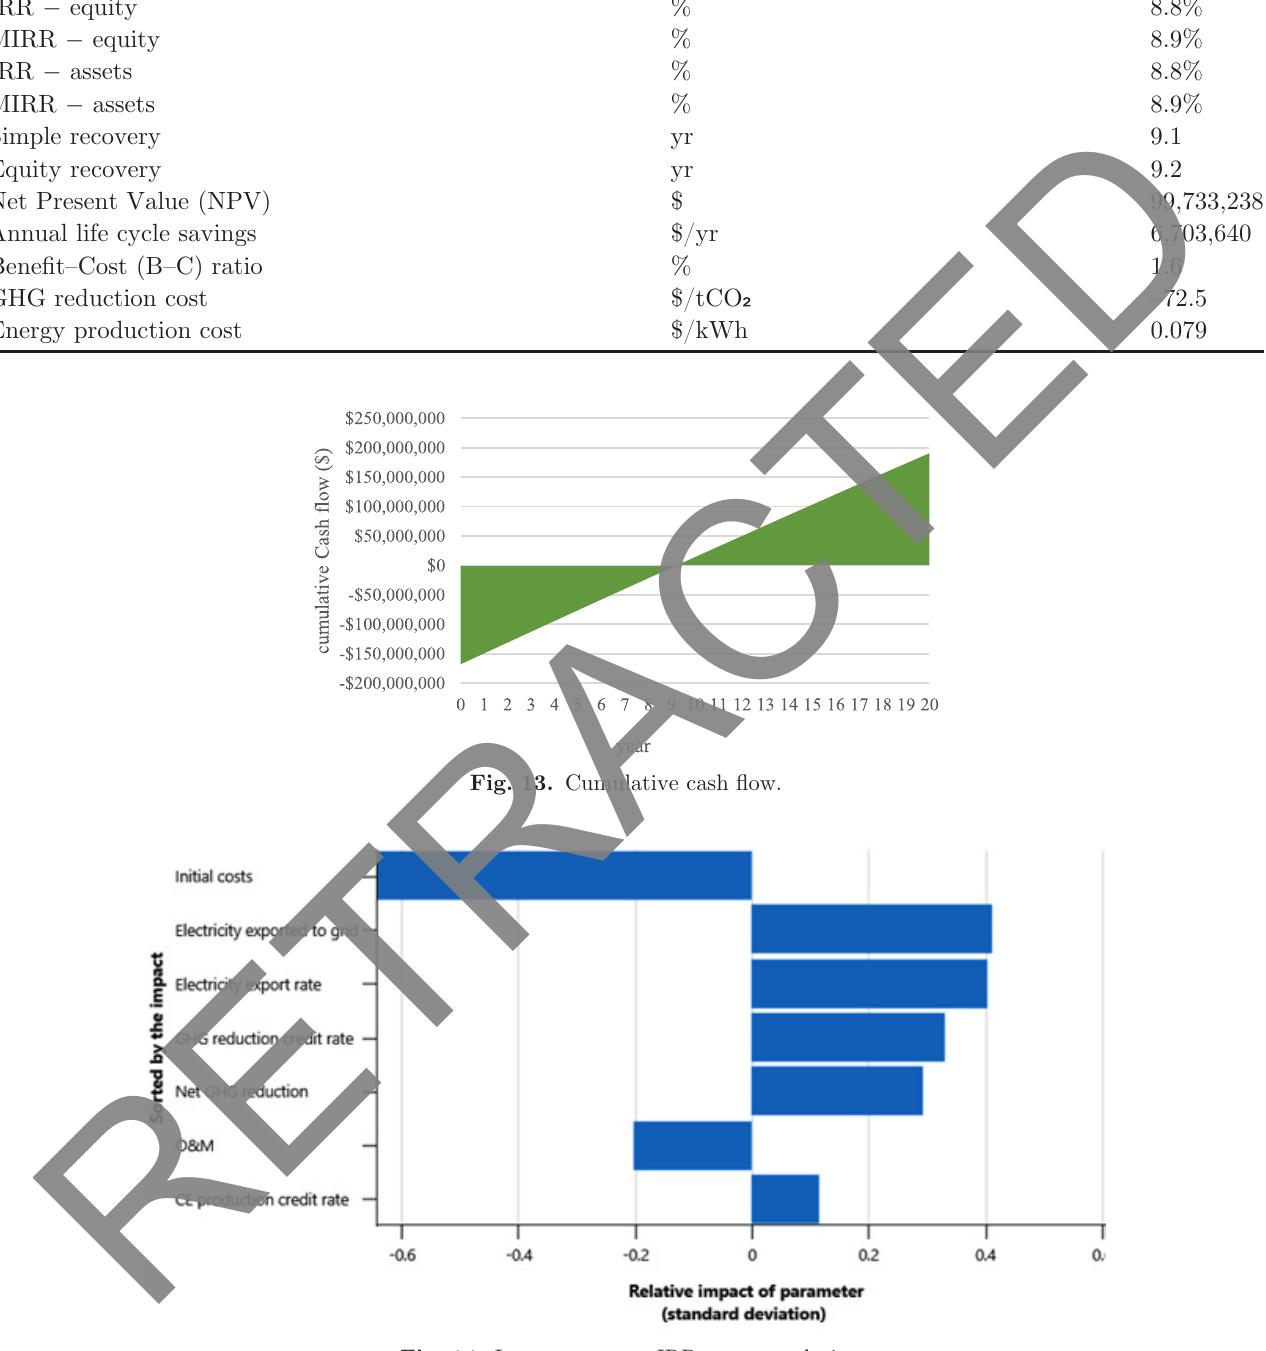
Fig. 14. Impact- pre-tax IRR-assets